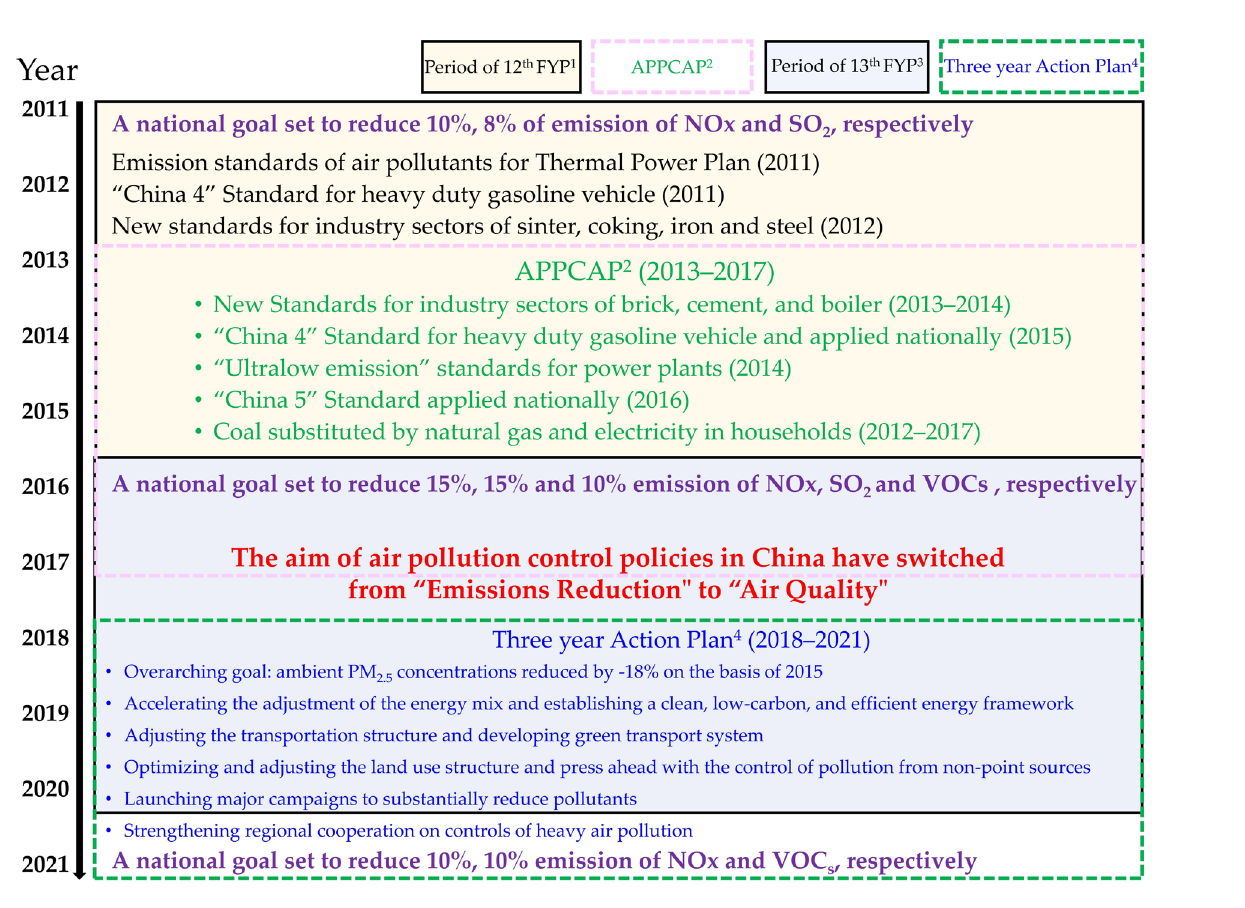
Figure 1. Timeline summarizing major air pollution control strategies in China. 1 The 12th Five Year Plan (2010–2015), the overarching goal was set to reduce 10% and 8% national NOx and SO 2 emission with a result of 18.6% and 18% reductions in national NOx and SO 2 emissions, respectively. 2 Air Pollution Prevention and Control Action Plan (2013–2017) aimed to reduce 25%, 20% and 15% PM 2.5 in Beijing-Tianjin-Hebei region (BTH), YRD (YRD) and Pearl River Delta (PRD), respectively. 3 The 13th Five Year Plan (2016–2020), the overarching goal was set to reduce 15%, 15% and 10% national NOx, SO 2 , and VOCs emission, respectively. 4 Three-Year Action Plan for Winning the Blue Sky Defense Battle (2018–2021). The Action Plan puts forward six measures with quantifiable indicators and timelines. After that, the overarching goal was set to reduce 10% and 10% national NOx and VOCs emission in the 14th Five Year Plan (2021–2025), respectively.